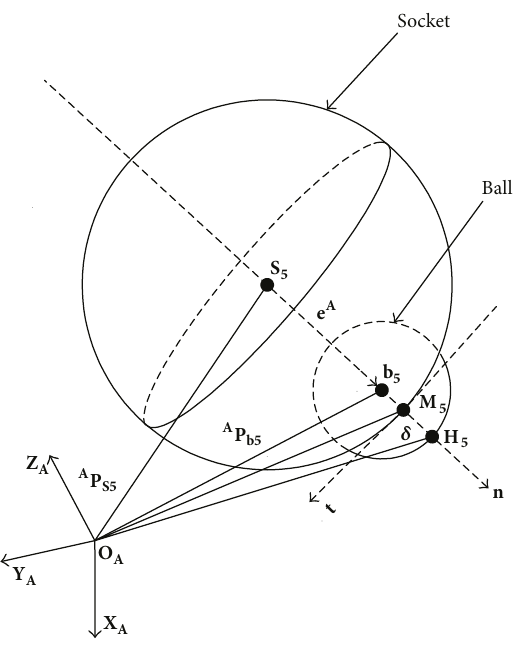
Figure 4: Coordinate system of spherical joint with clearance.